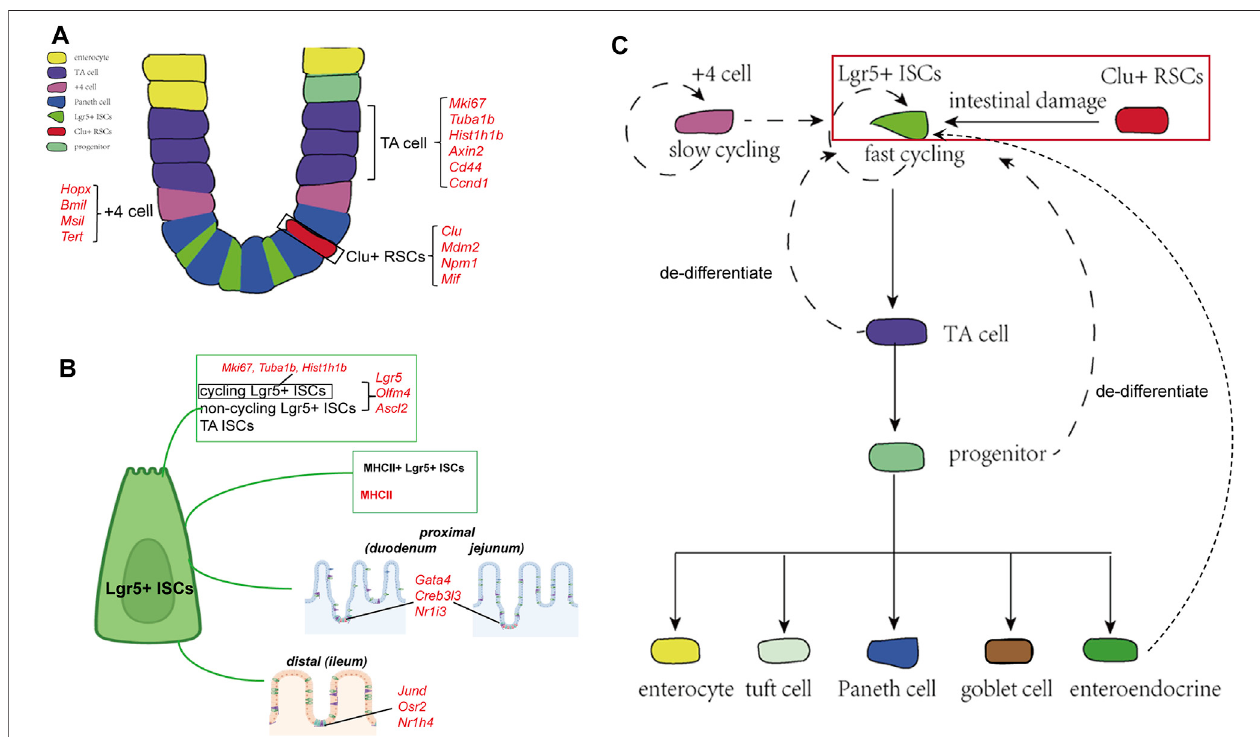
FIGURE 1 | Cellular components and the derivation or differentiation of intestinal epithelium. (A) Architecture and cellular components of the intestinal epithelium. The intestinal epithelium folds into millions of crypts and villi. Rapidly dividing ISCs reside at the bottom of the crypt, giving rise to TA cells that fi nally differentiate into fi ve different mature intestinal epithelial cell types: enterocytes, Paneth cells, goblet cells, EECs, and tuft cells. Clu + RSCs are extremely rare under homoeostatic conditions and canrepopulatethepoolofLgr5 + ISCs. (B) LandmarkgenesofLgr5 + ISCs basedonsingle-cellsequencing results. Cyclingand non-cycling Lgr5 + populations strongly expressed canonical CBC genes (Lgr5, Olfm4, and Ascl2). Cell cycle mRNAs (Mki67, Tuba1b, and Hist1h1b) are speci fi cally segregated to cycling Lgr5 + cells. Moreover, two Lgr5 + ISCs subtypes that speci fi cally expressed MHCII are identi fi ed by scRNA-sq. Lgr5 + ISCs in different regions of the intestinal tract express region- speci fi c marker genes. (C) The derivation and differentiation of ISCs. ISCs in crypts can replenish the whole crypt-villus axis, generating all differentiated cell types required for the physiological function of the intestine.